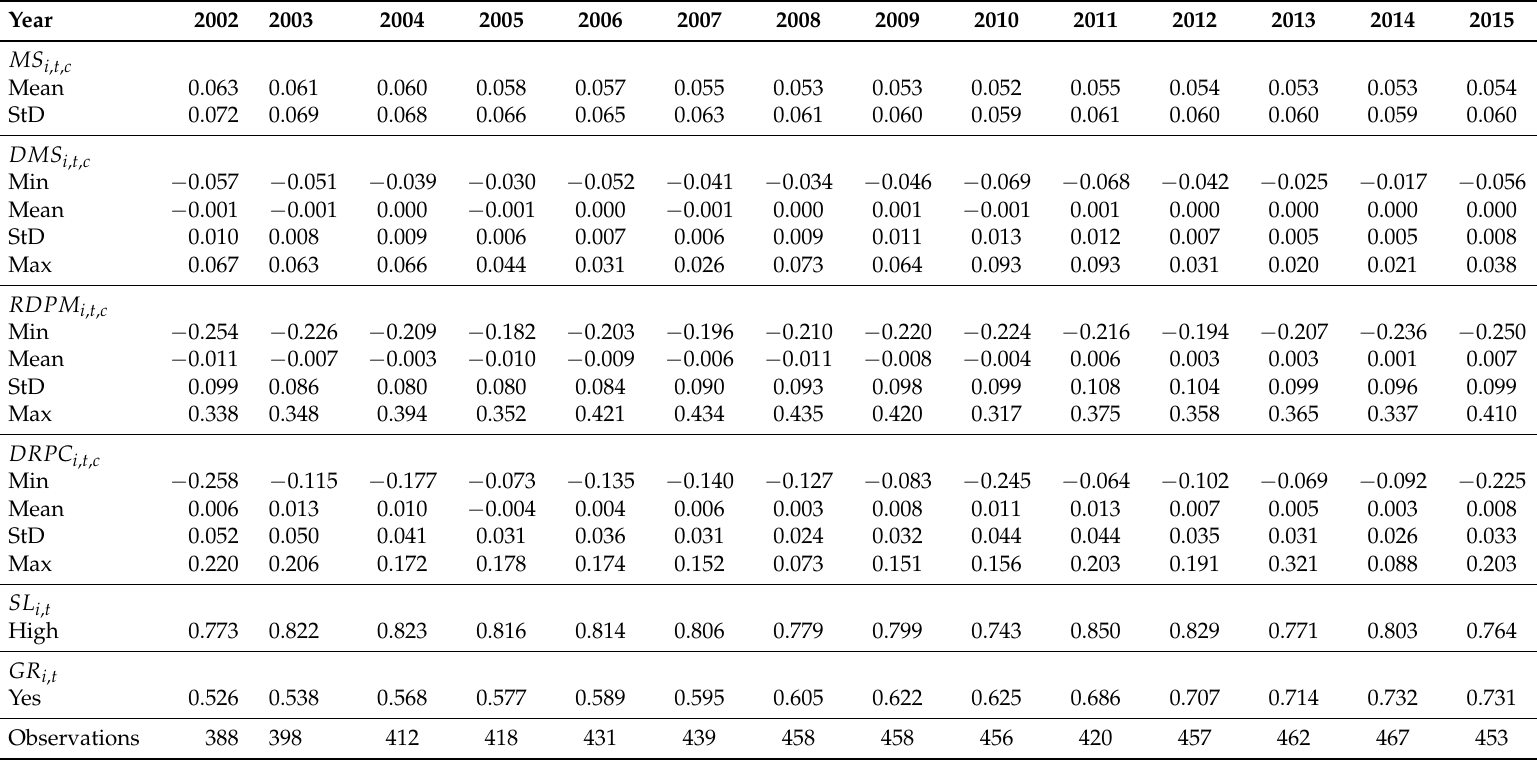
Table A2. Basic statistics of the variables: DMS i , t , c , RDPM i , t , c , DRPC i , t , c , SL i , t and GR i , t